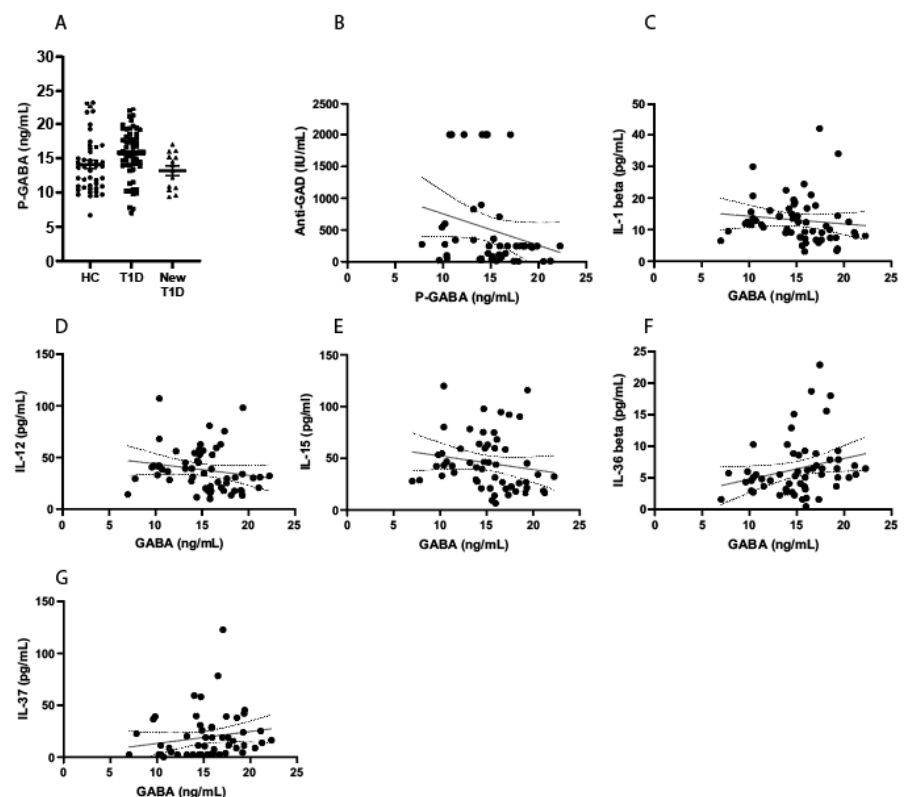
Figure 1. Circulating endogenous GABA levels in healthy controls and patients with type 1 diabetes. ( A ) The systemic endogenous levels of GABA were detected using mass spectrometry in healthy controls (HC, n = 45), patients with long-standing type 1 diabetes (T1D, n = 60), and in patients with new-onset T1D (New T1D, n = 13). No difference in circulating GABA levels was observed in T1D patients when compared to healthy controls. Values are presented as mean ± SEM. ( B ) Among the patients with T1D, n = 45 were positive for GAD-autoantibodies and among these patients, a negative correlation with GABA levels was observed ( r = − 0.3, p = 0.03). Note that the upper limit for the clinically used GAD autoantibody assay is 2000 IU/mL. ( C – F ) Correlations with the circulating endogenous GABA levels and circulating cytokines were computed in T1D patients ( n = 56) and were found to be negatively correlated with circulating levels of IL-1 beta ( C ), IL-12 ( D ) and IL-15 ( E ), whereas the GABA levels were positively correlated with IL-36 beta ( F ) and IL-37 ( G ). Endogenous GABA levels were negatively correlated to age in both HC ( r = − 0.35, p = 0.02) and long-standing T1D patients ( r = − 0.33, p = 0.009). In patients with